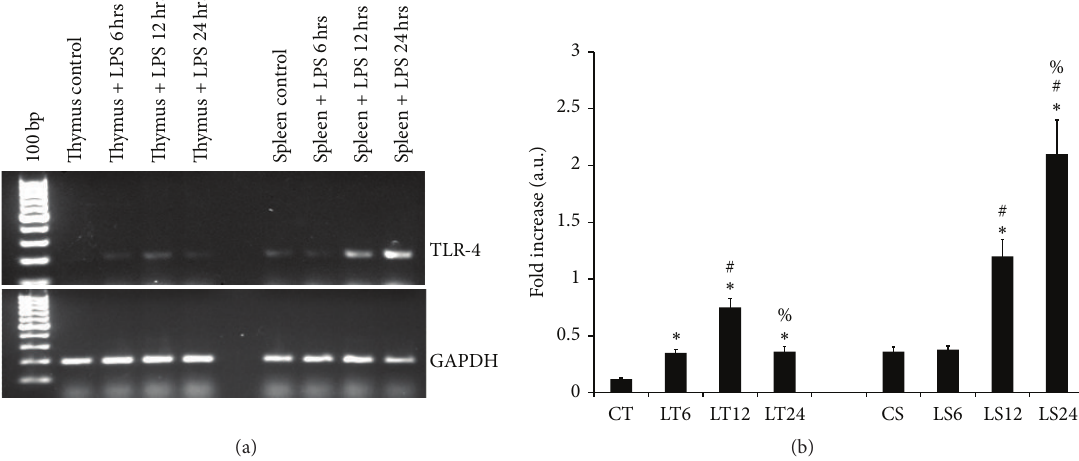
Figure 1: mRNA expression of TLR-4 in the spleen and thymus: the results in this figure (a) represents the differential transcription of tlr- 4 gene on LPS administration in thymus and spleen of Swiss albino mice from triplicate experiments; lane 1 represents TLR-4 mRNA in thymus from control mice (CT), lane 2 thymus from LPS treated mice at 6 hours after treatment (LT6), lane 3 thymus from LPS treated mice at 12 hours after treatment (LT12), lane 4 thymus from LPS treated mice at 24 hours after treatment (LT24), lane 5 represents spleen from control mice (CS), lane 6 spleen from LPS treated mice at 6 hours after treatment (LS6), lane 7 spleen from LPS treated mice at 12 hours after treatment (LS12), and lane 8 spleen from LPS treated mice at 24 hours post treatment (LS24). (b) Is the diagrammatic representation of the fold difference in their expression compare to control and among different time periods of treatment. Molecular weight marker (100bp). The following symbols indicates the significant change in the expression of TLR-4 between: ∗ control versus LPS treated tissue, # LPS treatment for 6 hours versus LPS treatment for 12 and 24 hours, % LPS treatment for 12 hours versus LPS treatment 24 hours. Significant change ( 𝑃 < 0.05